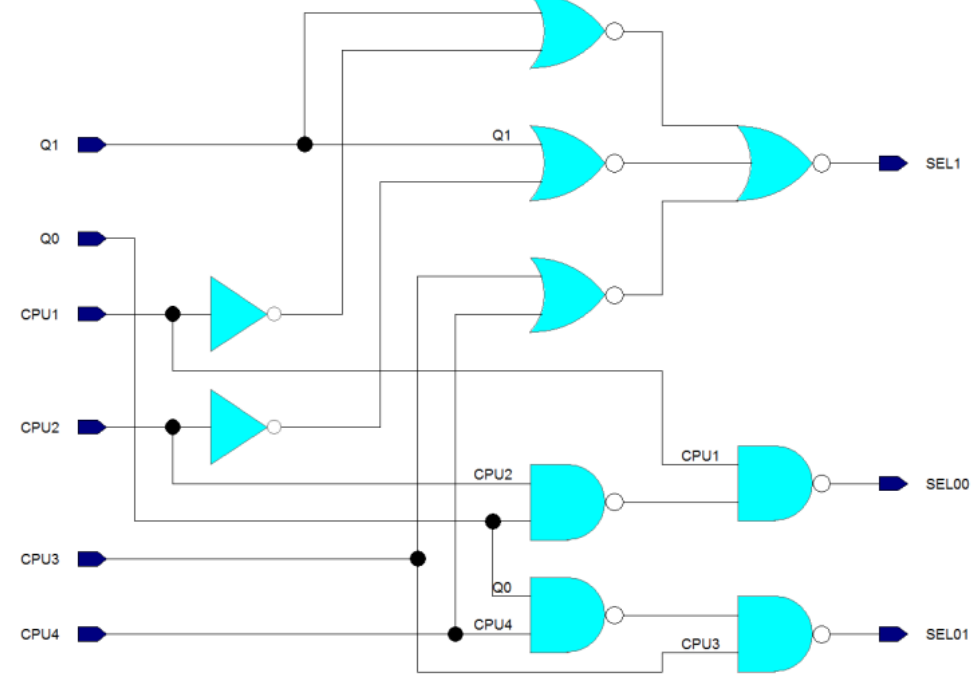
Figure 6. Winner Selector logic circuit.